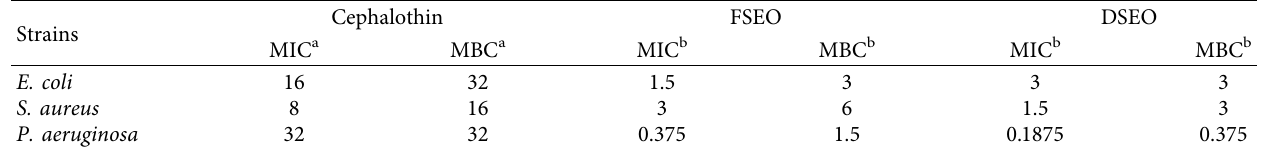
Figure 2: GC-MS of the essential oil from dried S. rugosoannulata fruiting bodies. Table 3: MIC and MBC of essential oils from fresh and dried S. rugosoannulata